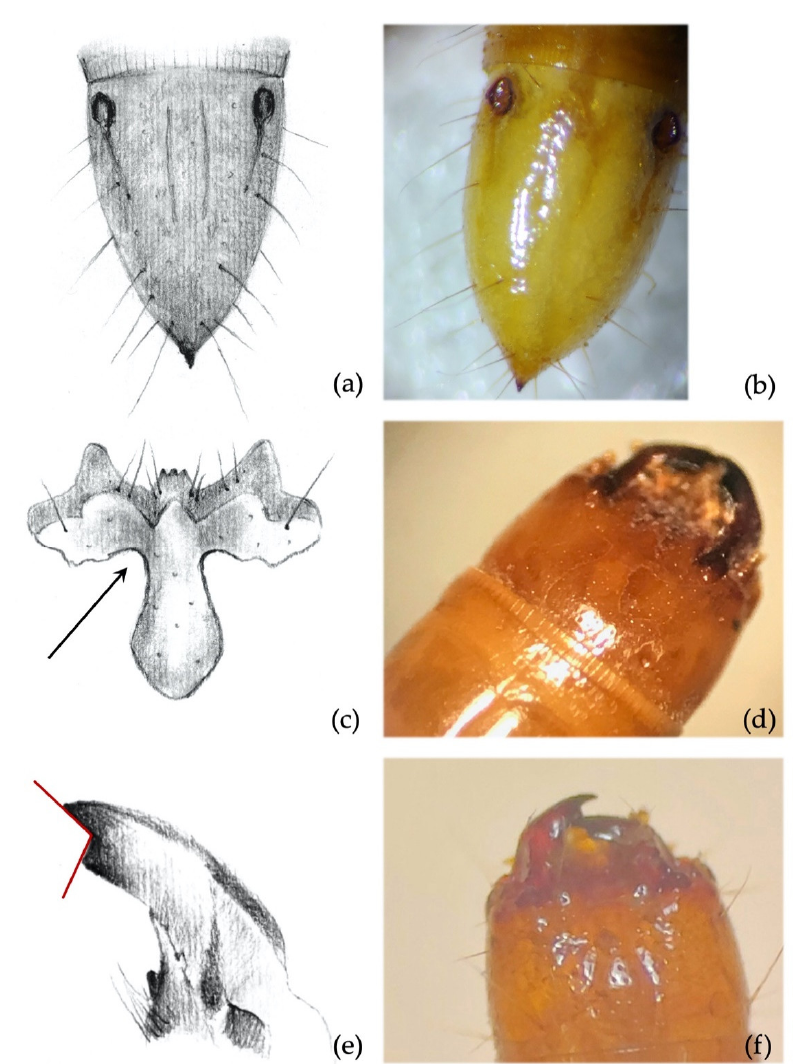
Figure 9. Agriotes brevis (Cand è ze 1863). Discriminating characters: ( a , b ) dorsal view of 9th abdominal segment, 1.5 × longer than wide; ( c ) details of the frontoclypeus commonly forming an angle <90 ◦ ; ( d ) view of frontoclypeus on the head; ( e ) details of the right mandible with subapical tooth forming an angle slightly >90 ◦ ; ( f ) view of mandibles on the